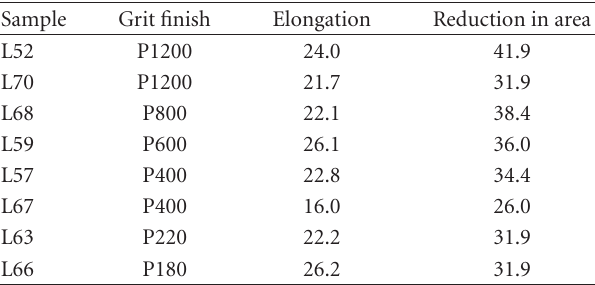
Table 6: Results of the slow strain-rate tests performed at 45 ◦ C, total pressure of 800 kPa, and 25% CO for di ff erent surface